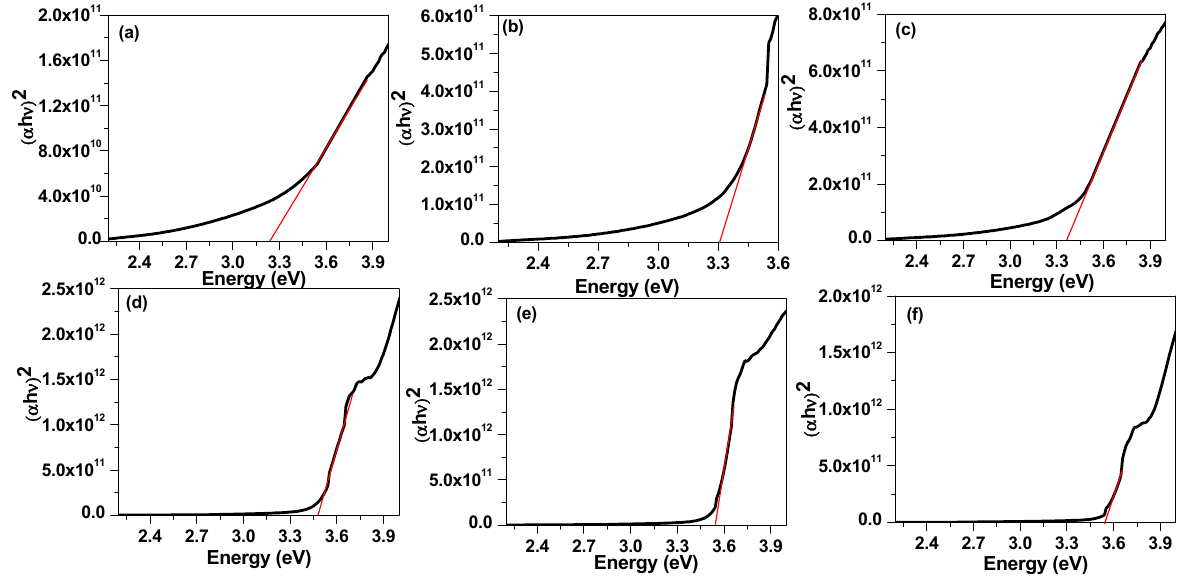
Figure 7. Tauc Plot (black line) of ( a ) I6, ( b ) I8, ( c ) I16, ( d ) I6/8, ( e ) I6/16 and ( f ) I8/16. The evaluation of band gap was carried out from the intercept of tangent (red line) on energy axis.